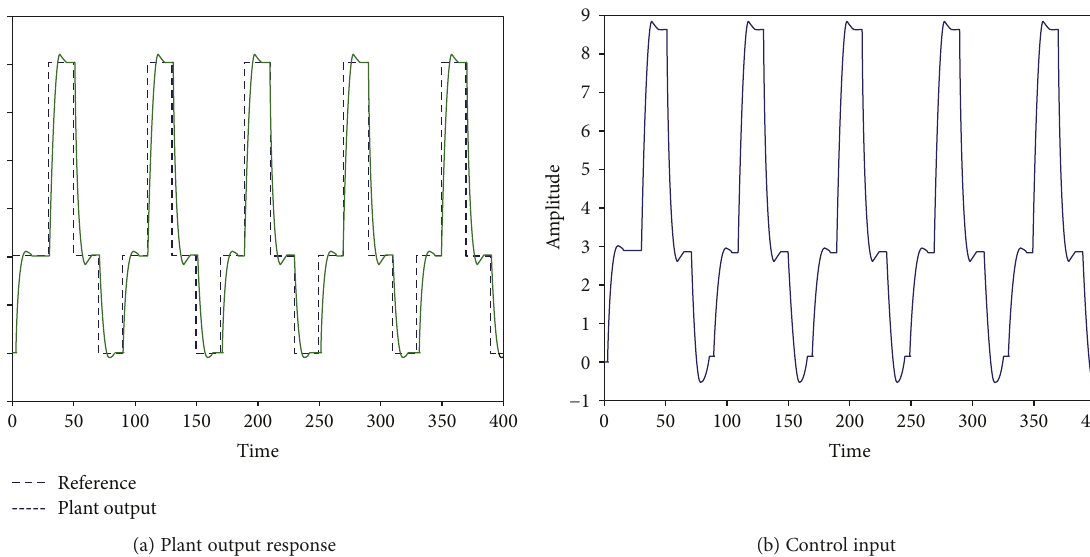
Figure 6: Plant output and control